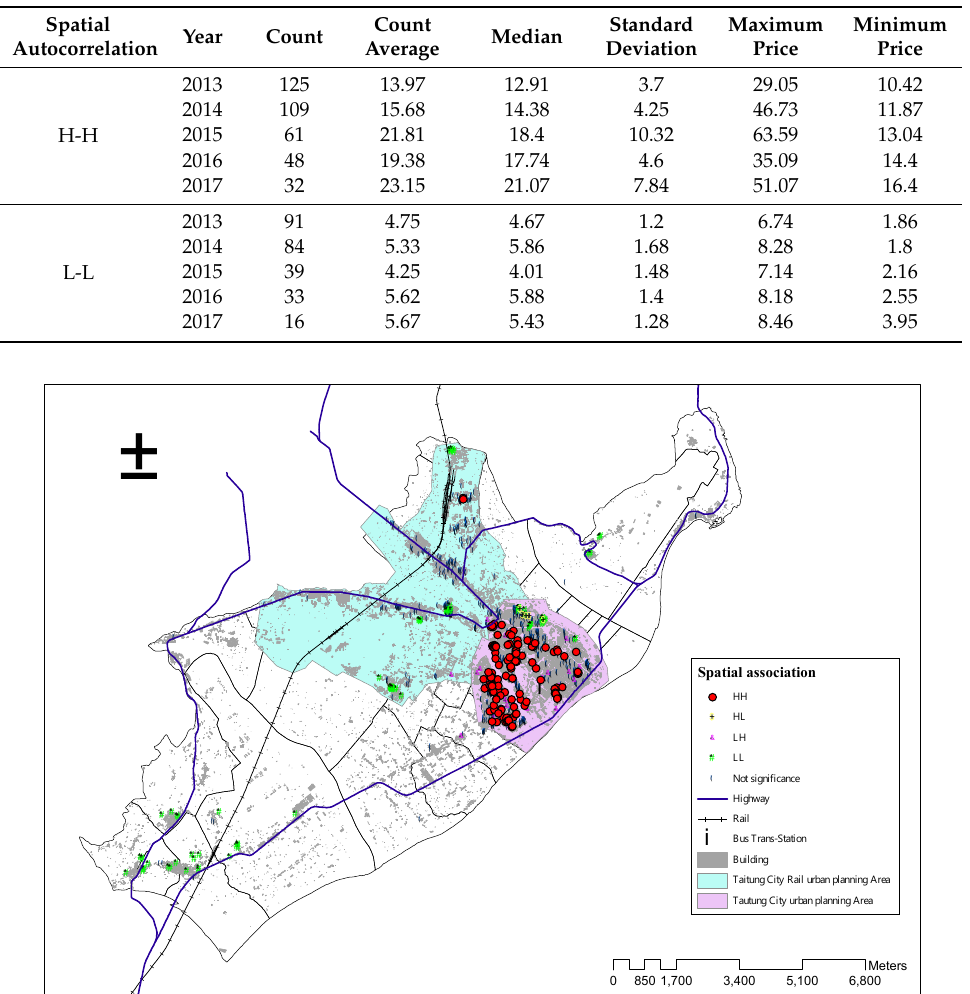
Figure 3. Spatial correlation map of real estate unit price in 2013.